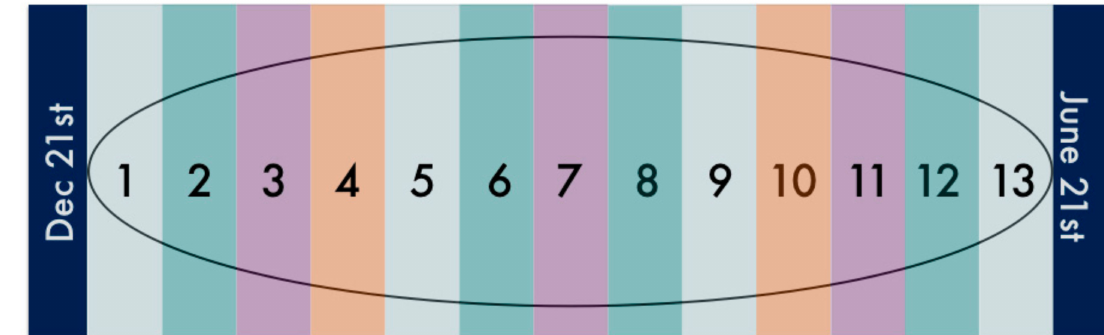
Figure 1. Daylight Indices as a measure of daylight hours. The ellipse represents a full calendar year. The closest 4 weeks (7 December–3 January) surrounding 21 December are the darkest and correspond to Index 1. The next closest 2-week periods (23 November–6 December and 4–17 January) correspond to Index 2, and so on. The brightest 4 weeks of the year correspond to Index